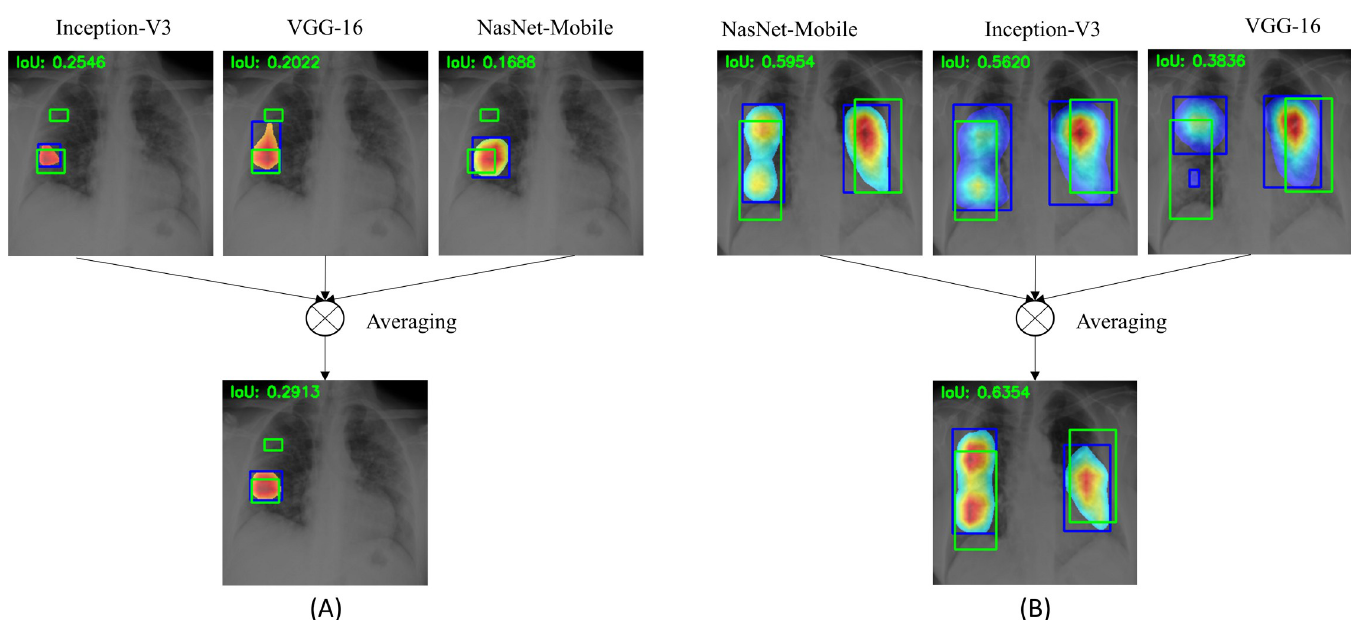
Fig 15. Instances of ensemble CRMs combining top-N ensemble ROI predictions. (A) top-3 CNNs using STAPLE-generated consensus ROI annotation; (B) top-5 CNNs using Rad-2 annotations. The green box denotes reference ROI annotation and the blue box denotes ensemble CRM localization.